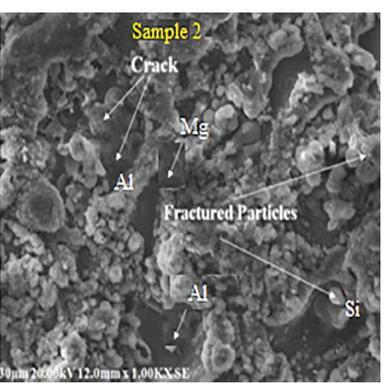
CAST MMNC Sample S2 at 30 mm Scale Range.